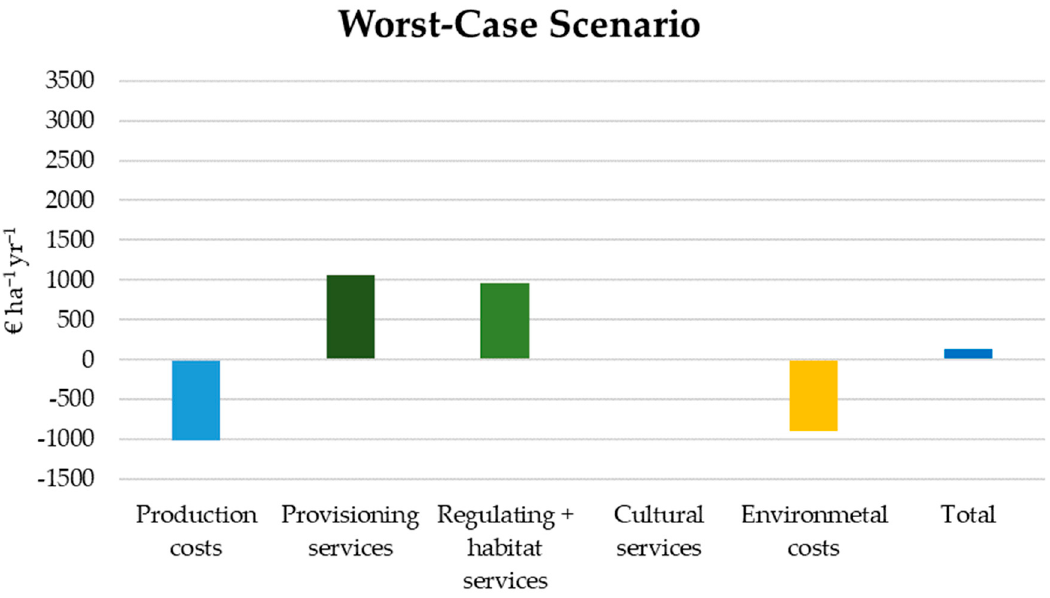
Figure 4. True costs and benefits in the worst-case scenario assuming minimum ESs provision and high monetization factors for environmental impacts.